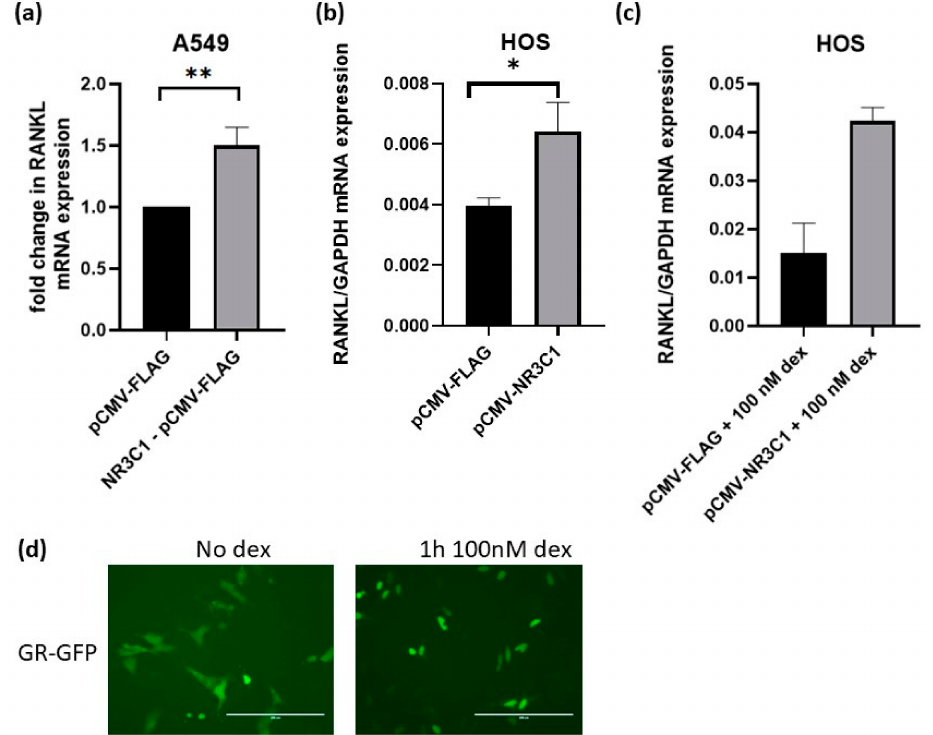
Figure 5. Overexpressed glucocorticoid receptor NR3C1 upregulates expression of RANKL in A549 and HOS cells. ( a , b ) A549 and HOS cells were transfected with pCMV-NR3C1 or empty plasmid (pCMV-FLAG) and 72 h after transfection RNA was isolated and level of RANKL mRNA measured by quantitative PCR. ( c ) HOS cells were transfected with NR3C1 or empty plasmid and treated with 100 nM dexamethasone for 72 h when the level of RANKL expression was measured. ( d ) HOS cells were transfected with fluorescently tagged GR (GR-GFP) and 24 h after transfection exposed for 1 h to 100 nM dexamethasone. Translocalisation of GR to the nucleus was observed. All of the data are presented as mean relative RANKL expressions after normalization with GAPDH expression. The results are expressed as the mean ± SEM. *– p < 0.05, **– p < 0.01, Scale bars: 200 µ